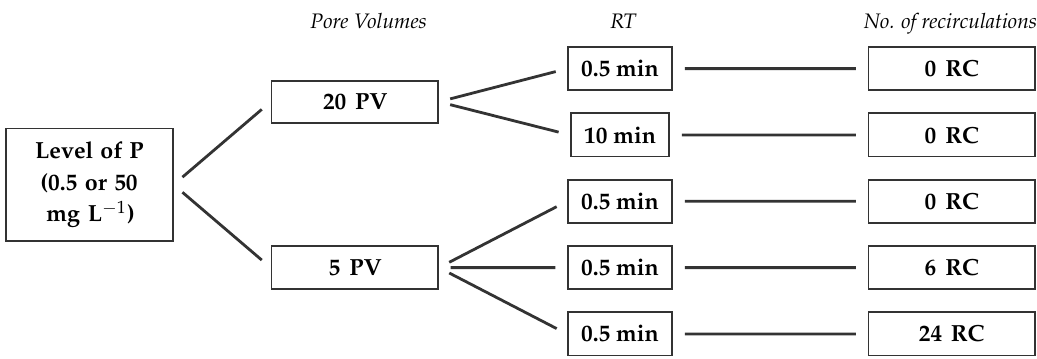
Figure 1. Experimental conditions and phosphorus (P) regeneration treatments tested. PV = pore volume; RT = residence time; RC = recirculation. 225